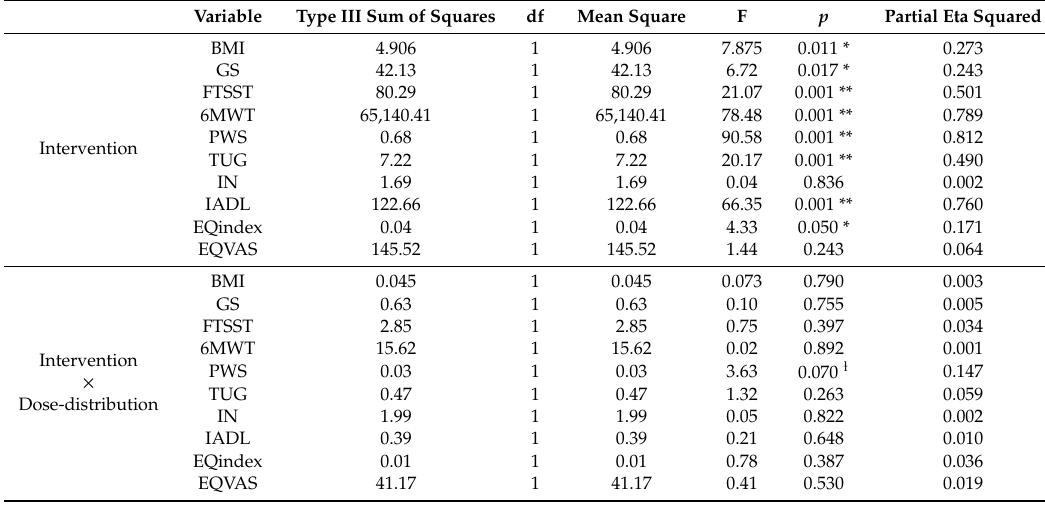
Table 3. Tests of within-subjects’ e ff